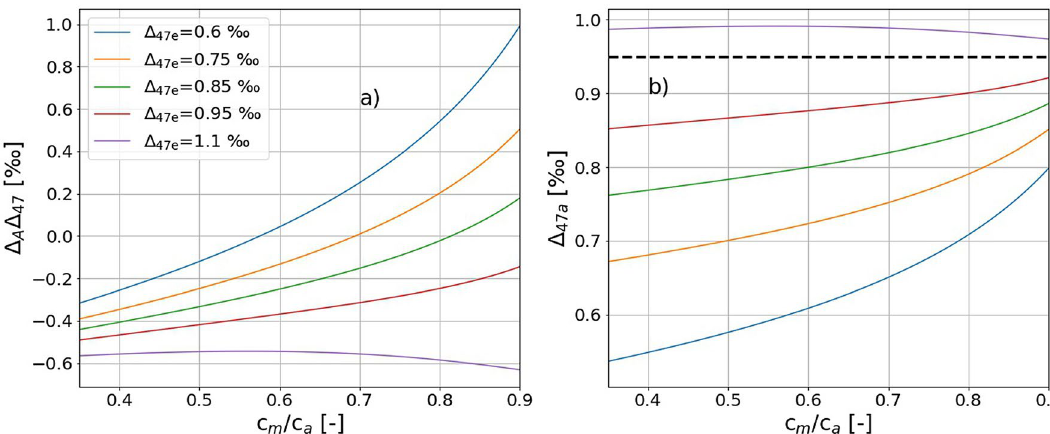
Figure 7. Leaf cuvette model result for Δ 47 photosynthetic discrimination. ( a ) Δ A Δ 47 as a function of c m / c a for various value of Δ 47e (see legend). Panel ( b ) shows the corresponding value for Δ 47a , the black dashed line indicates the Δ 47 of CO 2 at the CO 2 -H 2 O exchange site for the leaf temperature of 20